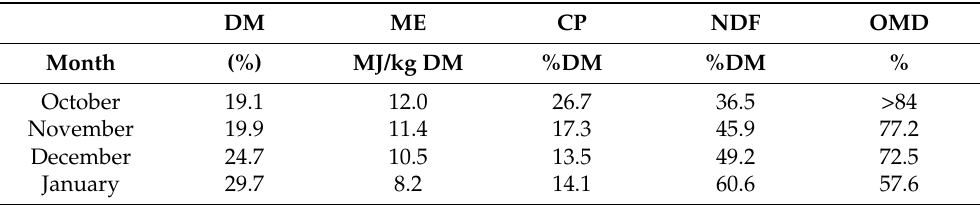
Table 1. Pasture analyses using the near-infrared reflectance spectroscopy technique based on dry